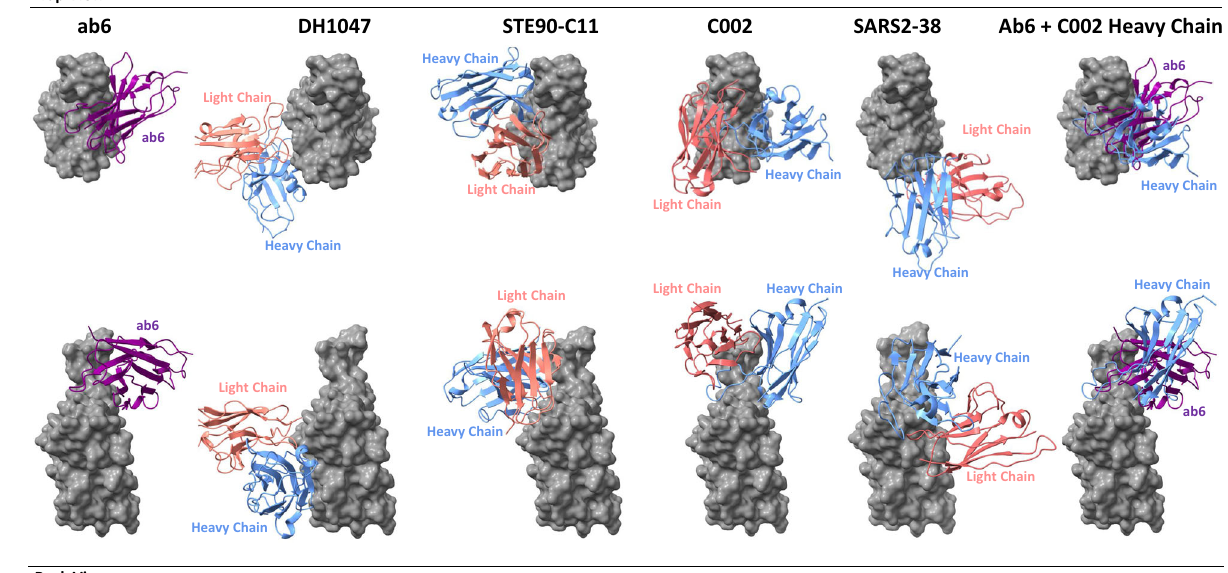
Fig. 6 | Footprint comparison between ab6 and selected RBD-directed anti- bodies. The RBD is depicted as a gray molecular surface and antibodies are depicted as colorized cartoon models. The following PDB fi les were utilized: 7LD1